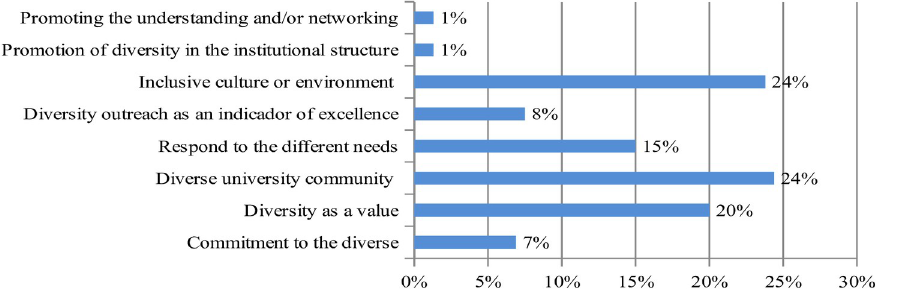
Fig 4. Distribution of frequency coding according to the institutional